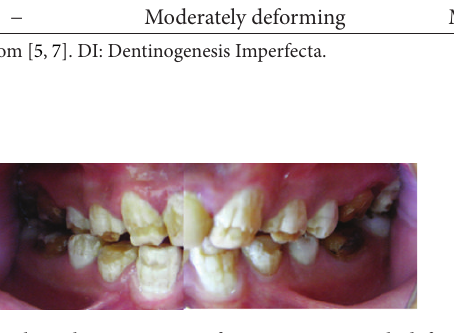
Figure 1: Clinical appearance of extensive enamel deformities chipped during